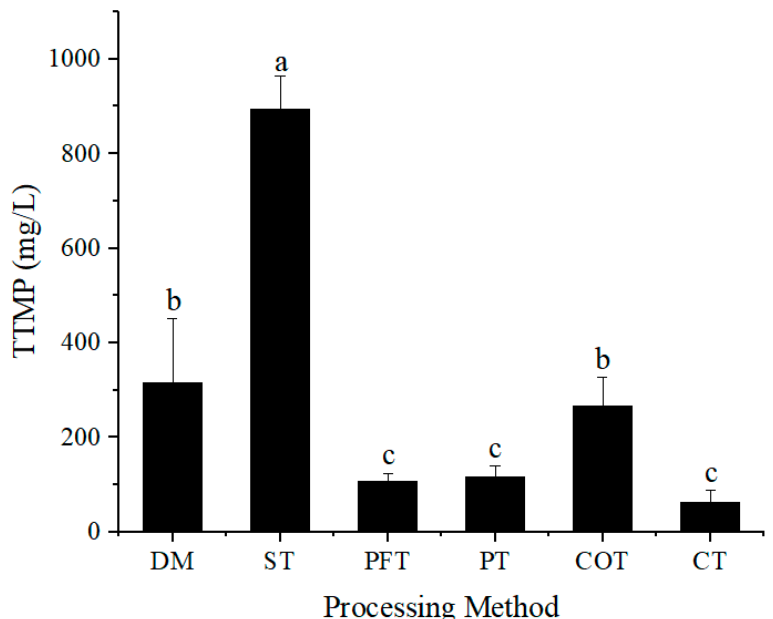
Figure 6. TTMP production from 150 g/L molasses with different treatment methods. DM represents untreated molasses. ST, PT, PFT, COT and CT represent sulfuric acid treatment process, phosphoric acid treatment process, potassium ferrocyanide treatment process, calcium phosphate tribasic treatment process, combinational treatment process, respectively. Data were obtained from triplicate tests and shown as mean ± SD. Bars with a same superscripted letter (a, b or c) mean that there is no statistical